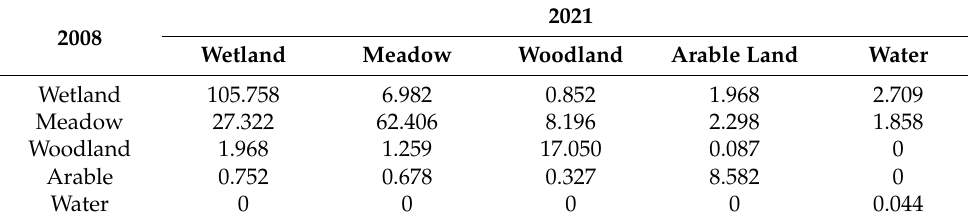
Table 2. Transfer direction between different landscape types in the HNNR from 1985 to 2008. 1985 Wetland Meadow Woodland Arable Land Water Wetland 107.483 Meadow 10.295 Woodland